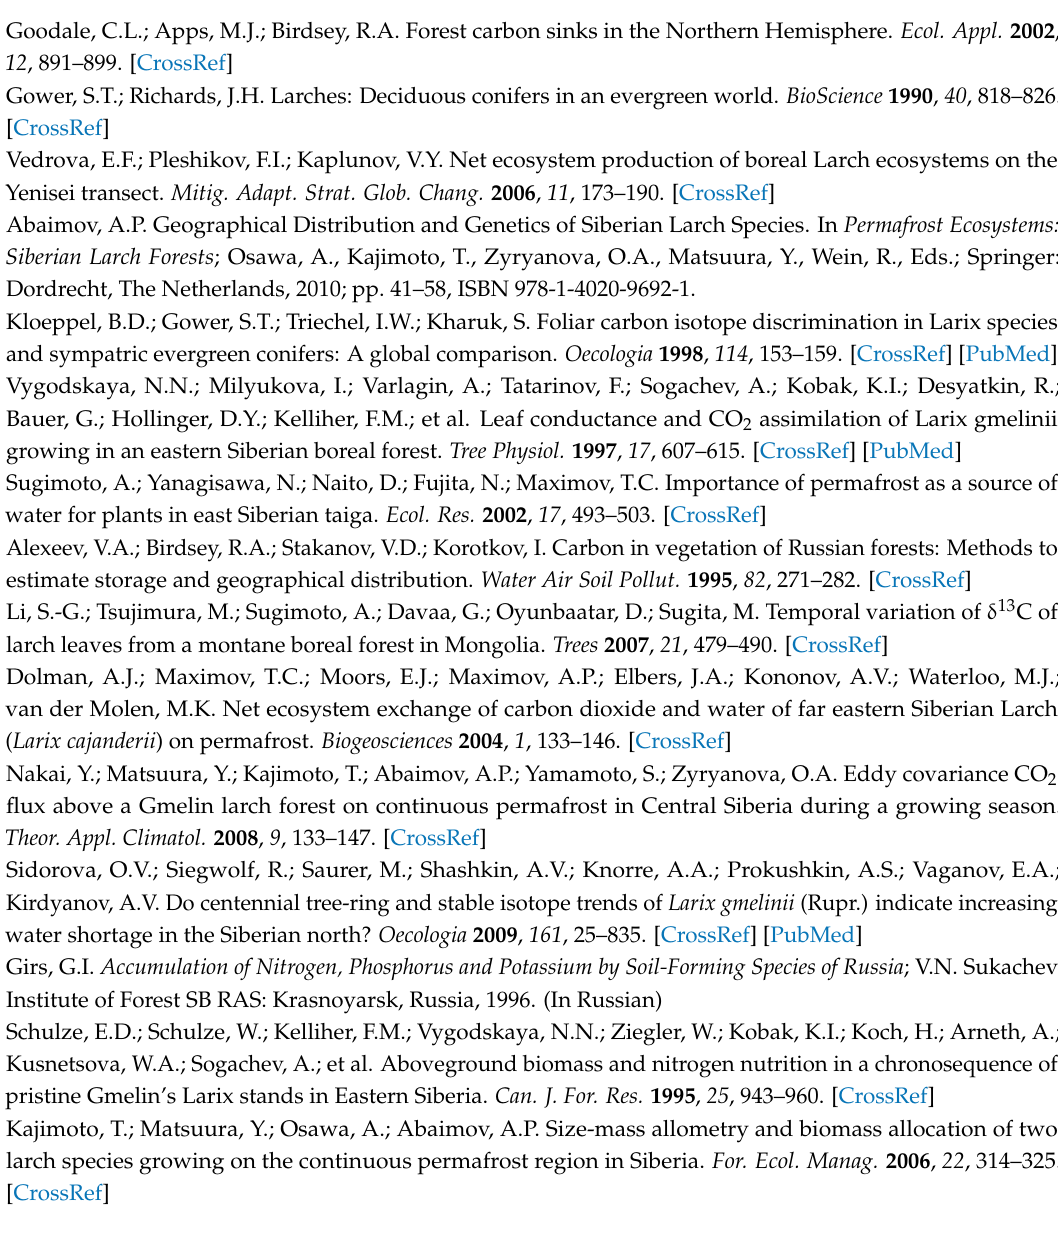
Table S1: Site- and fraction-specific allometry equations, Table S2: Statistical significance of the linear mixed model testing the effects of active layer thickness and time (Julian day in the growing season) on element concentrations and isotopic